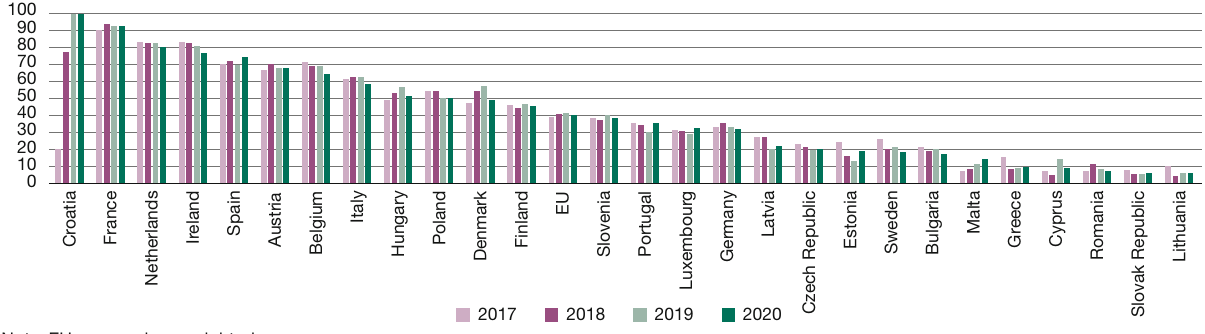
Note: EU average is